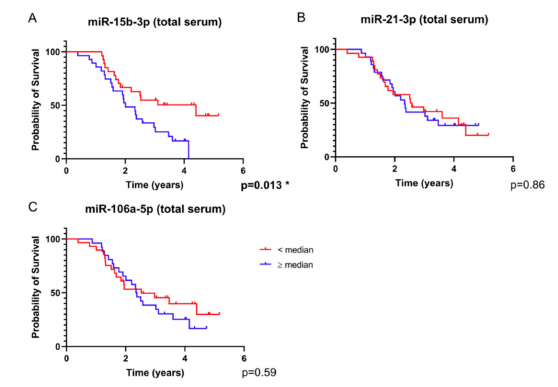
Figure 5. Survival analysis based on total serum microRNA expression. Depicted are survival curves using a dichotomous assessment based on microRNA levels (( A ) miR-15b-3p, ( B ) miR-21-3p, ( C ) miR-106a-5p) from total serum of glioblastoma patients ( n = 55). Red color indicates patients with values equal to or higher than the median and blue color represents values lower than the median normalized expression ratio. For miR-328-3p, no graph was generated because more than 50% of the values were non-measurable. Note that the separation of the curves based on miR-15b-3p is significant after Benjamini–Hochberg correction for multiple testing (Tables S3 and S4).